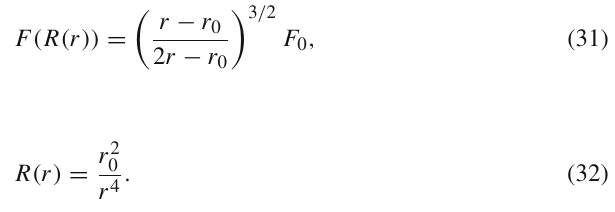
Fig. 1 The trend of the dimensionless f ( R ( r ))/ f ( R ( r 0 )) function and Ricci’s scalar R ( r ) against the dimensionless radial coordinate r / r 0 for = 1, F = − 1 and f = 10 (red curves) and m = 0, m = 1, β = r 2 0 0 0